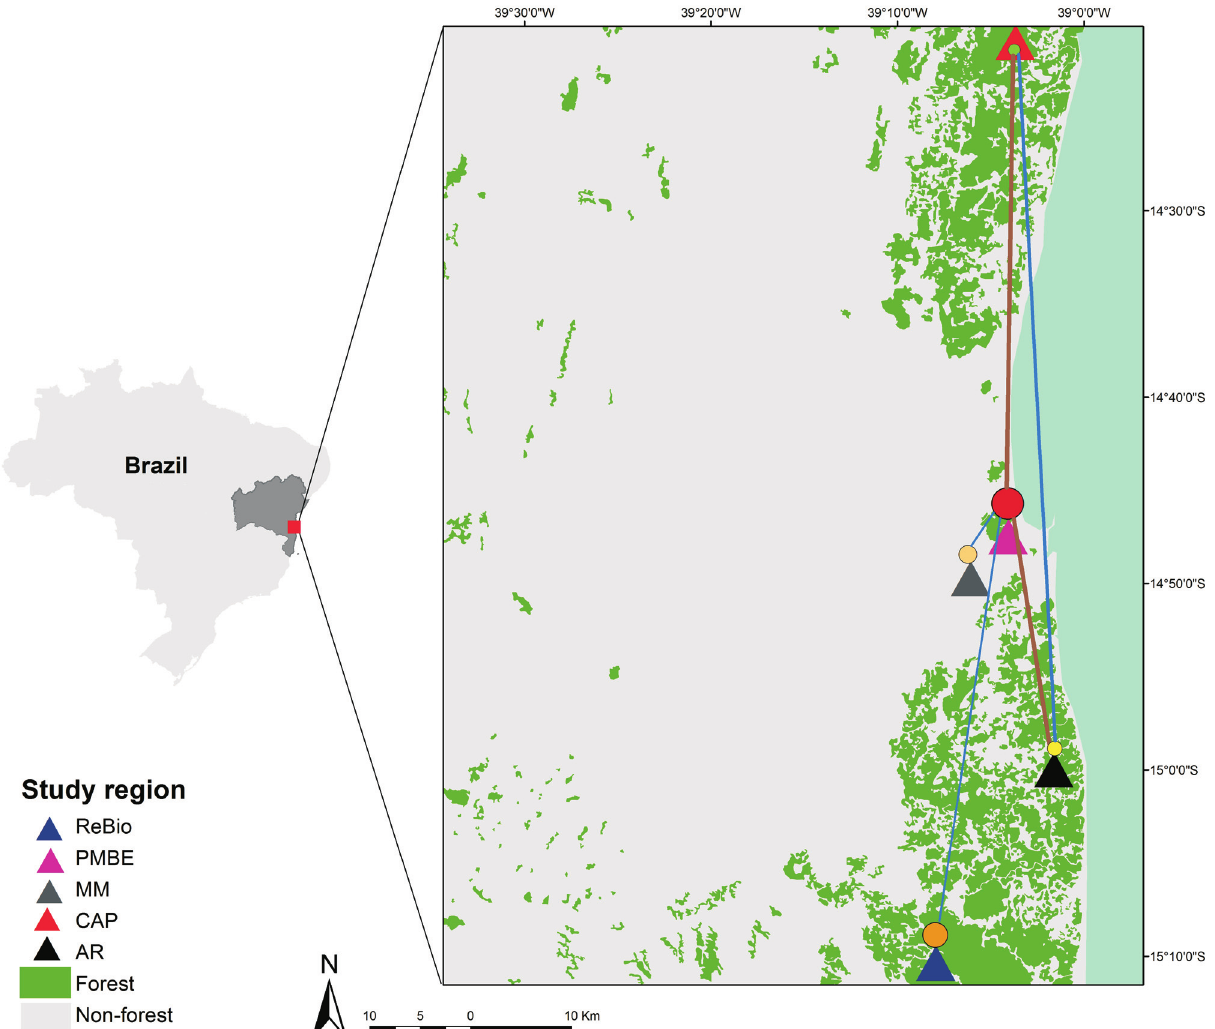
Figure1 -MapofBrazil.ThestateofBahiaishighlighted,indicatingtheregionofthestudy,withthecurrentforestcover.Blueandbrownlinesshownet- work linkages identified by EDENetworks (Kivelä et al. , 2015) between nodes (sampling sites), using cpSSR markers. Line thickness is proportional to linkage strength and node size is proportional to the number of haplotypes for each sampling sites de E. ovata . Map data: Atlas of the Atlantic Forest rem- nants of the year 2016, obtained from SOS Mata